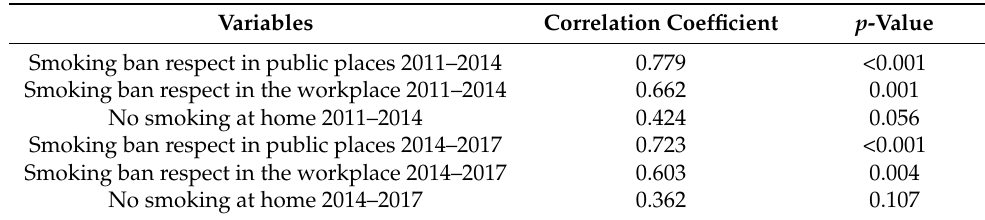
Table 2. Results of the bivariate analysis of correlates of GDP per capita. Variables Correlation Coefficient p